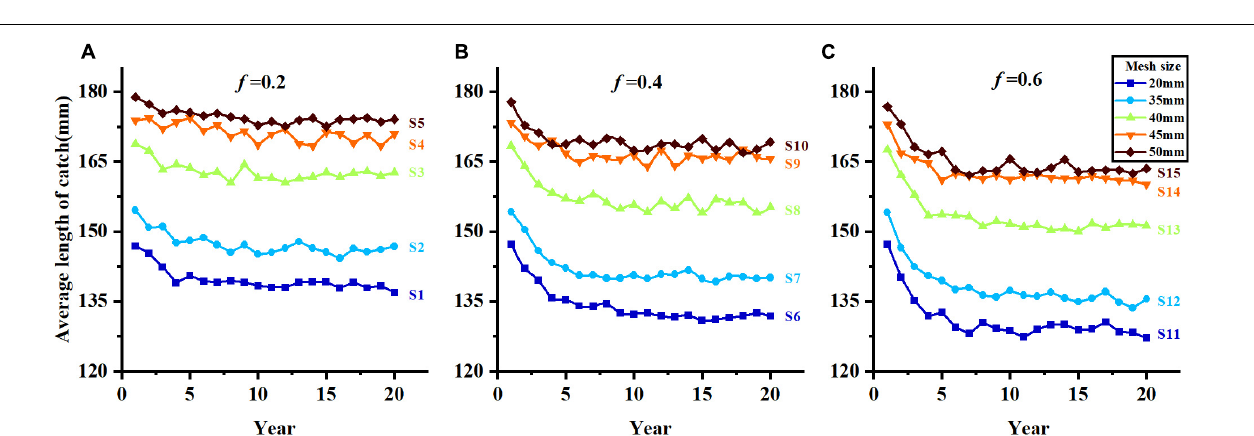
starts and lasts for 20 years. To test the model and the robustness of the 15 harvest scenarios, all results presented are repeated ten